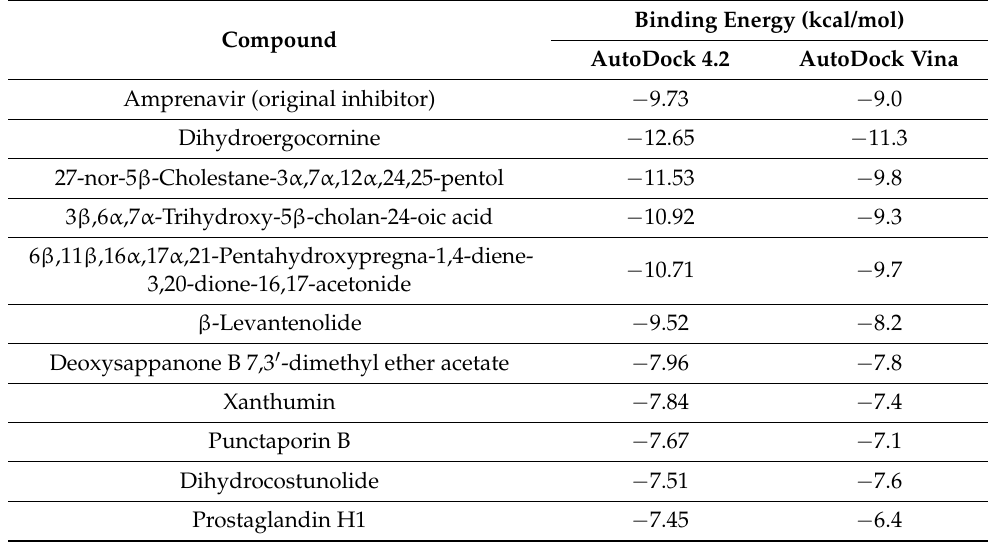
Table 2. Top 10 molecular docking results of CA-identified compounds at the active site of HIV-1 PR.